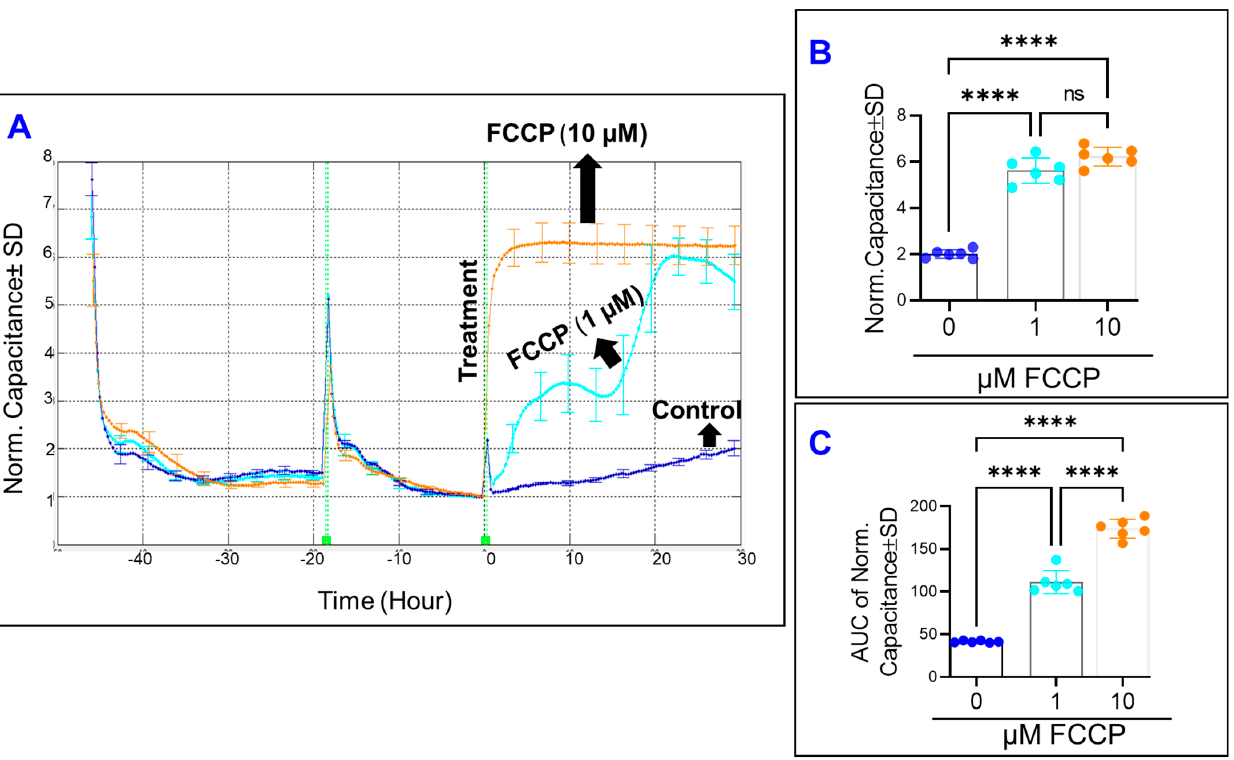
Figure 2. Real-time measurement of human retinal endothelial cells’ spreading capacity treated with OxPhos uncoupler (FCCP). ( A ) The spreading of HRECs over the electrode under the treatment of DMSO (vehicle) or FCCP (1 and 10 µM) was measured at an AC frequency of 64,000 Hz and represented as normalized capacitance vs. time. The capacitance value at time 0 (C 0 ) was used to normalize all other capacitance measurements. ( B ) The bar graph represents each group’s normalized capacitance at the time (t = 30 h). ( C ) The bar graph represents each group’s area under the normalized capacitance curve between the time interval t = 0–30 h. Statistical analysis was performed using the ANOVA test followed by the Tukey post hoc test. Abbreviations: Norm, normalized; AUC, area under the curve. ****, p ≤ 0.0001; ns, no significance.